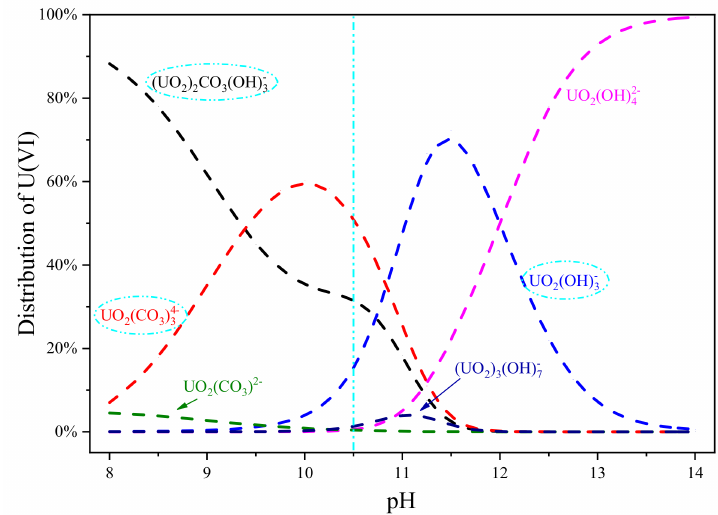
Figure 5. Distribution of uranium ions at pH 8–14 in this study system.